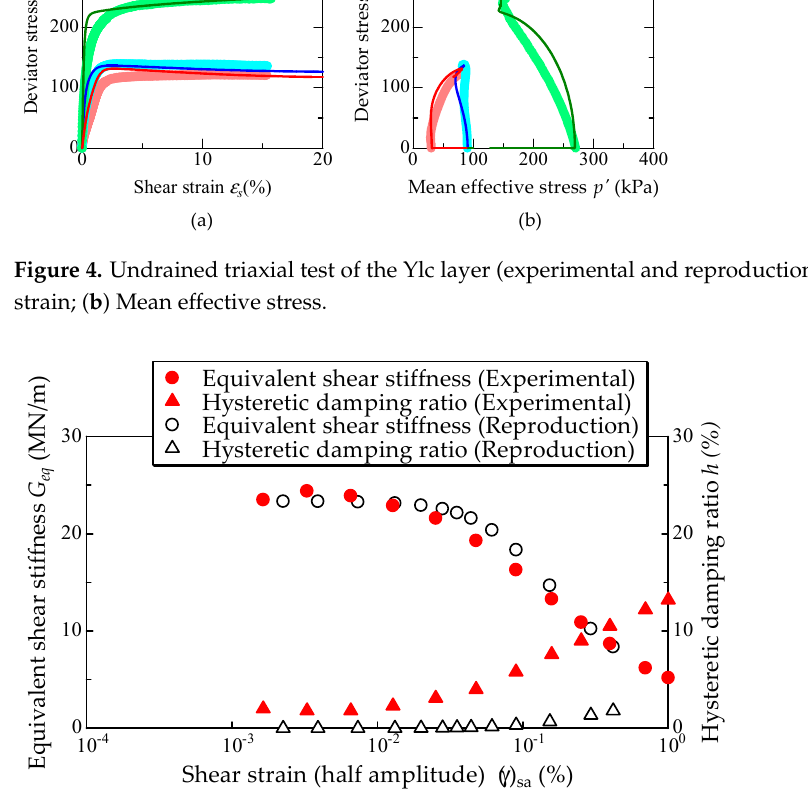
Figure 5. Dynamic deformation properties of the Ylc layer (experimental and reproduction results).